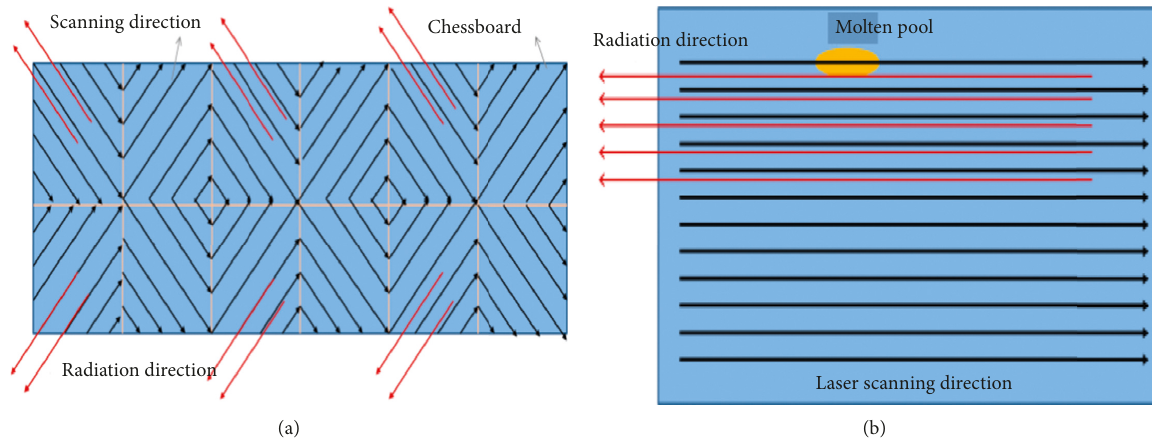
Figure 6: Radiation diagram under different scanning strategies. (a) Chessboard scanning. (b) Uniformity scanning.